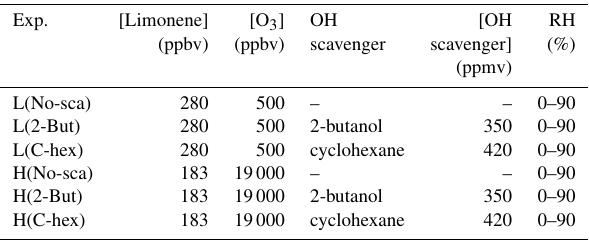
Table 1. Experimental